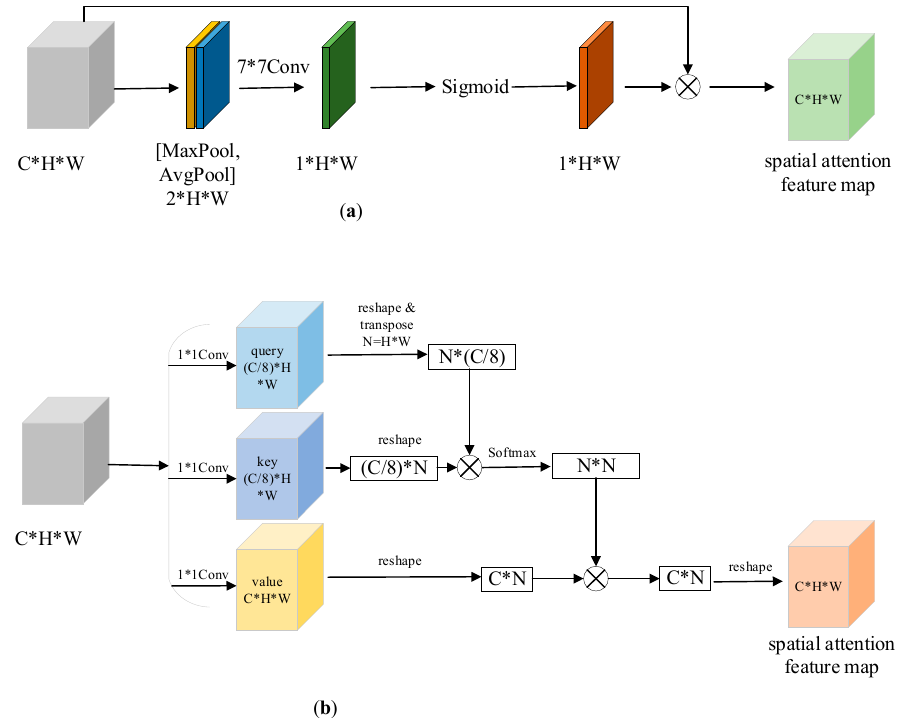
Figure 3. Two spatial attention feature maps’ generated methods. ( a ) shows the spatial attention method used in CBAM, and ( b ) shows the spatial attention methods used in DSANet. The “C” of “C/8” in ( b ) represents the number of channels. The computation of self-attention in CBAM would be reduced through reducing channels. In our work, the DSA module uses the attention method shown in Figure 3b to extract features.